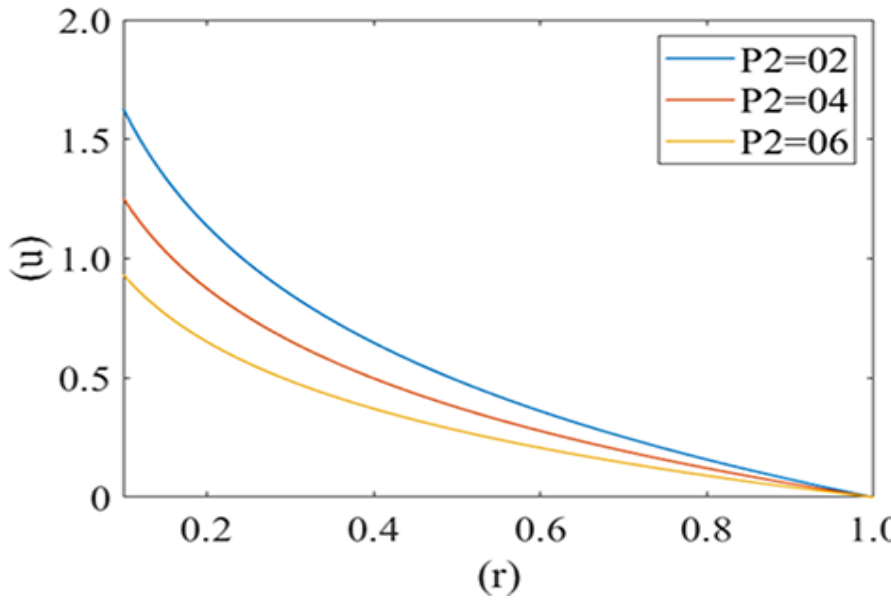
Figure 4. Variation of axial velocity component ( u ) of plasma film with deformed cell radius ( r ) in microcirculation with variation of local pressure ( P2 ) on the cell with Re = 0.25, P1 = 2.